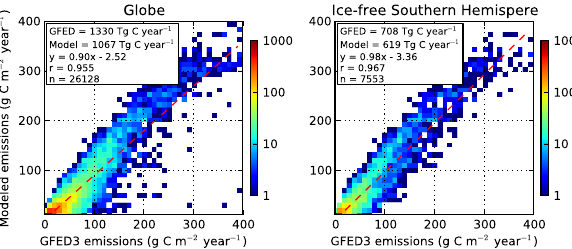
Fig. 7. Modelled emissions based on satellite-derived fire return times and the Olson equation versus GFED3 emissions for all ter- restrial 0.5 ◦ × 0.5 ◦ grid cells (left) and those in the Southern Hemi- sphere (right). The color scale indicates the number of 0.5 ◦ grid cells corresponding to emissions bins. Data is averaged over 1997– 2010. Least squares linear regression lines are shown in